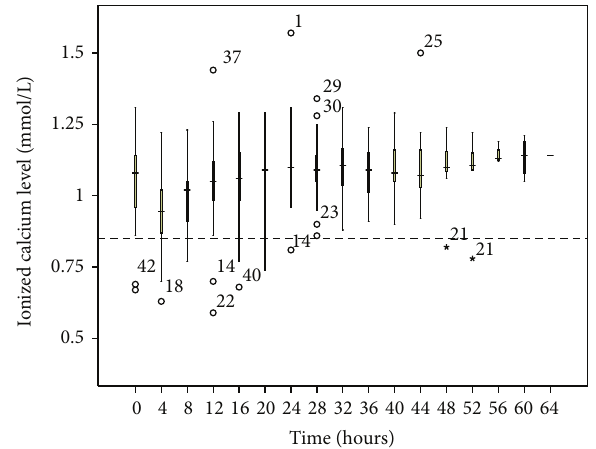
Figure 7: Phosphate changes over time during citrate CRRT. Standard box plot in which the horizontal line represents the median,thethicklinerepresentstheinterquartilerange,andthethin line represents the maximum and minimum values. The circular dots represent the outliers.